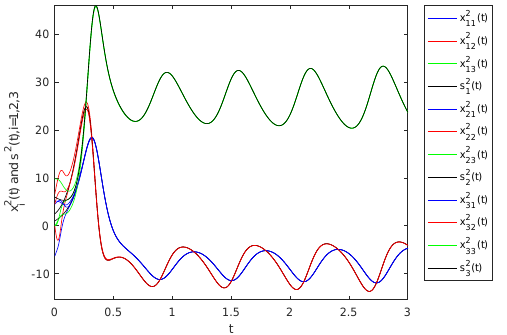
( 2 ) ( t ) and s ( 2 ) ( t ) under Controller ı